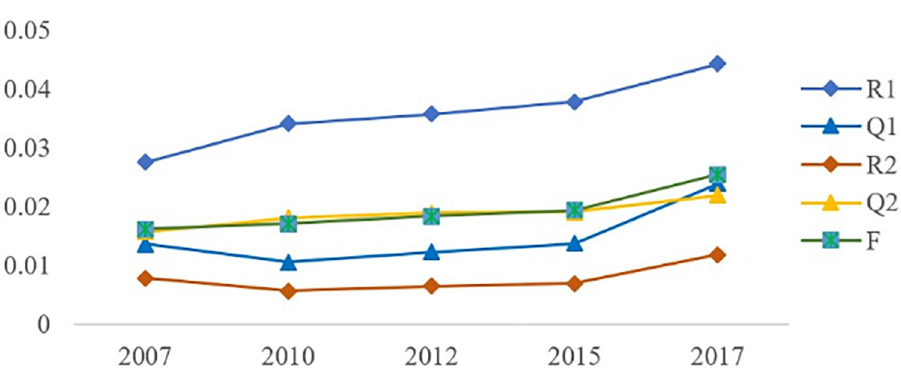
Fig 3. The integration level of China’s logistics industry and the core industry of the digital economy.